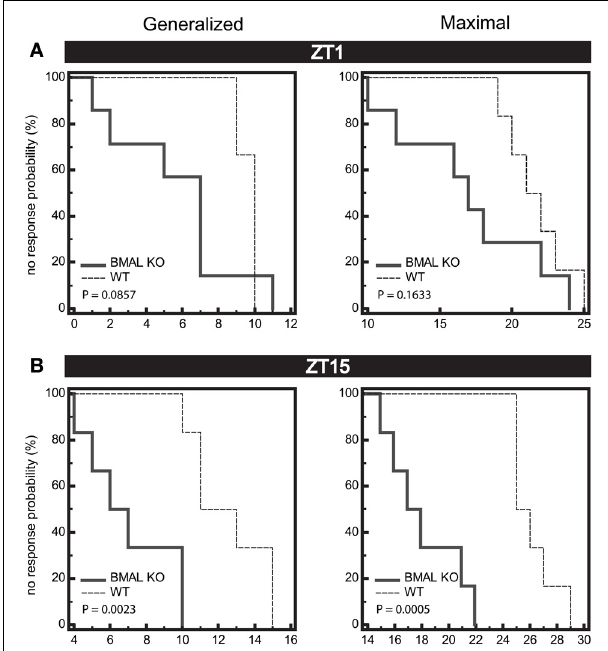
FIGURE 6 | Seizure endpoints are reduced in BMAL1 KO mice compared to WT. (A) and (B) Endpoints of electroshock-induced seizures comparing BMAL KO mice and WT mice from data combined in for the light-period ( A , ZT1) and dark-period ( B , ZT15) show differential percent probability of no response in both generalized (GEST) and maximal (MEST) electroshock seizure threshold. (A) ZT1, Median trial number to reach GEST: WT = 10, BMAL KO = 7; Logrank test, P = 0 . 0857; Median trial number to reach MEST: WT = 22, BMAL KO = 17; Logrank test, P = 0 . 1633, N = 6 per group. (B) ZT15, Median trial number to reach GEST: WT = 13, BMAL KO = 7; Logrank test, P = 0 . 0023; Median trial number to reach MEST: WT = 26, BMAL KO = 18; Logrank test, P = 0 . 0005; N = 6–7 per group.